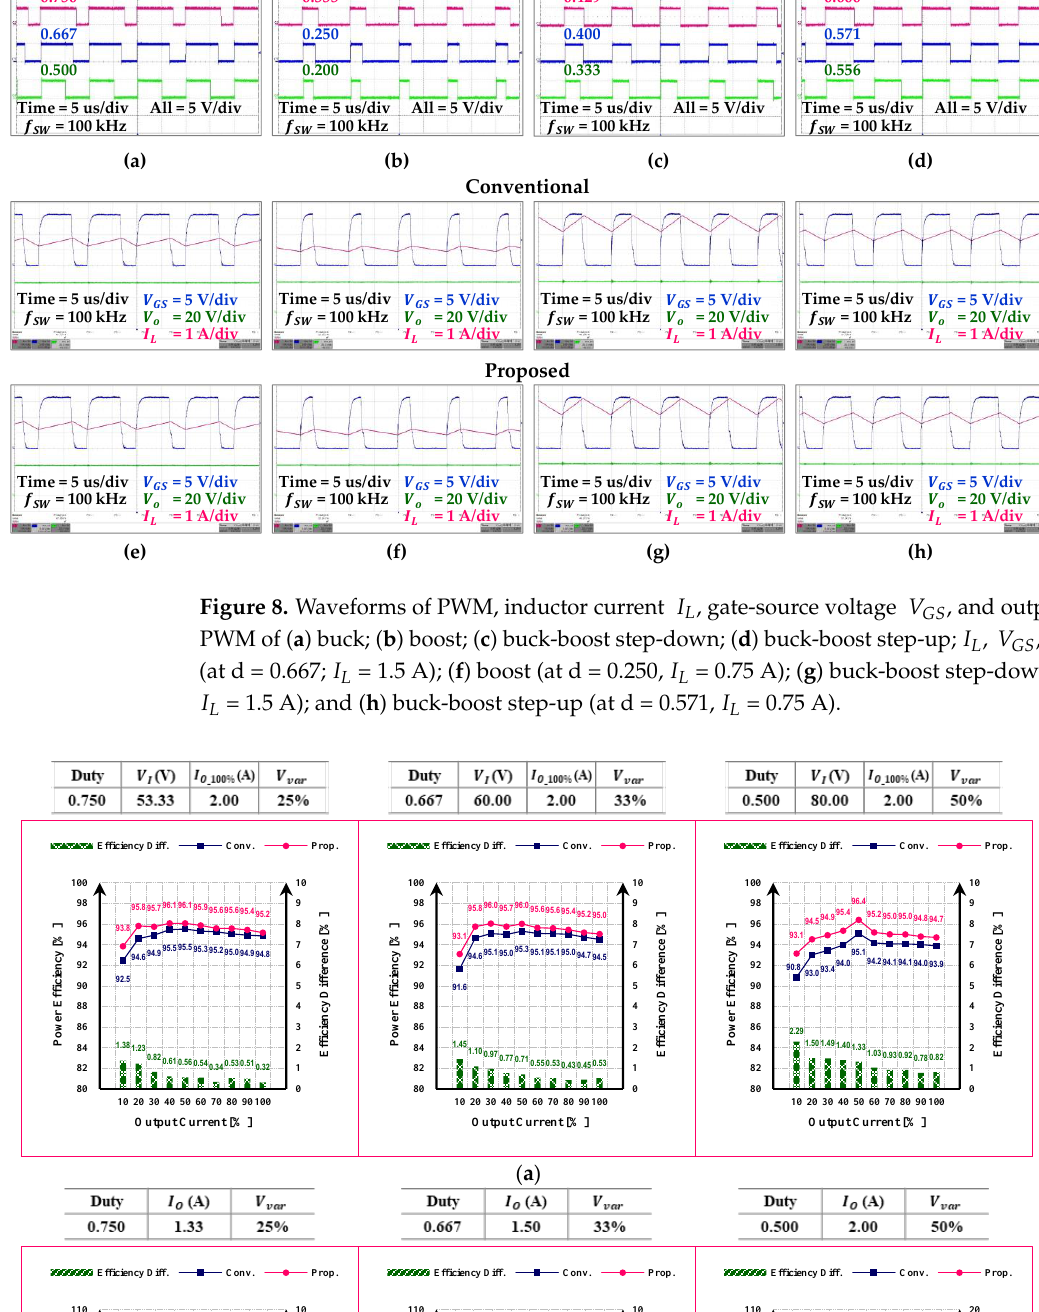
Figure 10 shows the power efficiency of the boost topology. The proposed converter shows the same power efficiency in the measured error range because it has the same number of semiconductors and the same stress as the conventional converter.